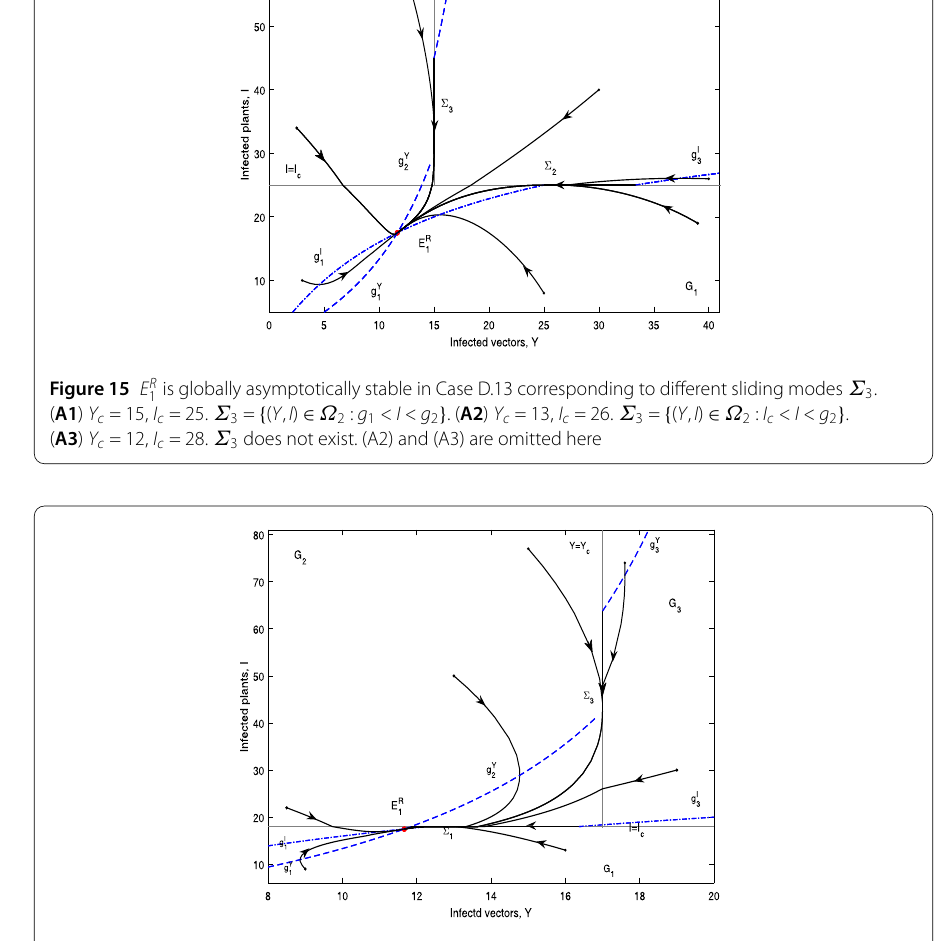
Figure 16 E R 1 is globally asymptotically stable in Case D.21. Y c = 17, I c =